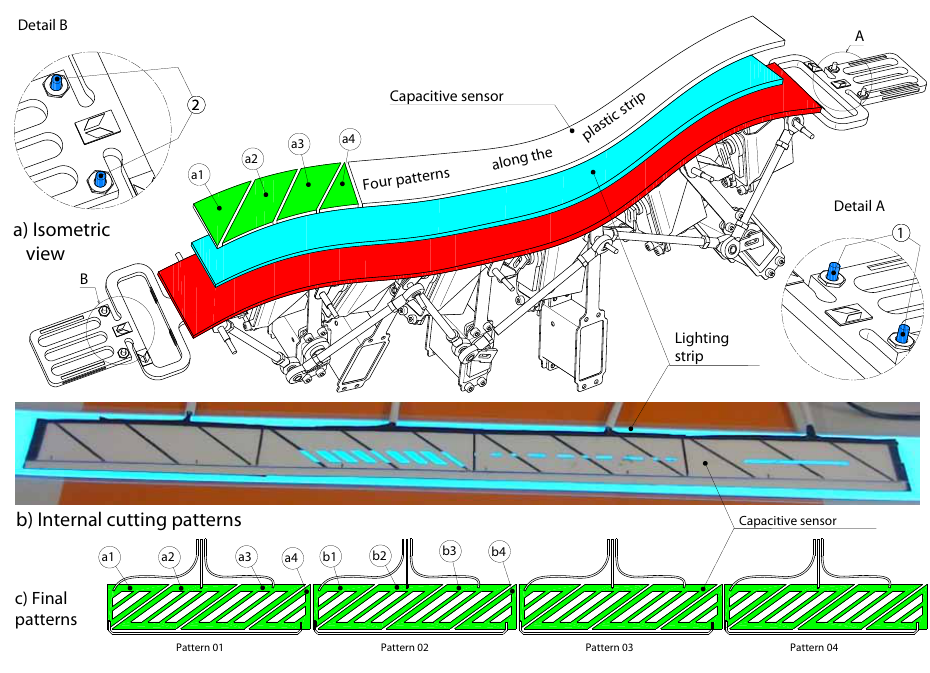
Figure 3. Flexible capacitive touch sensor